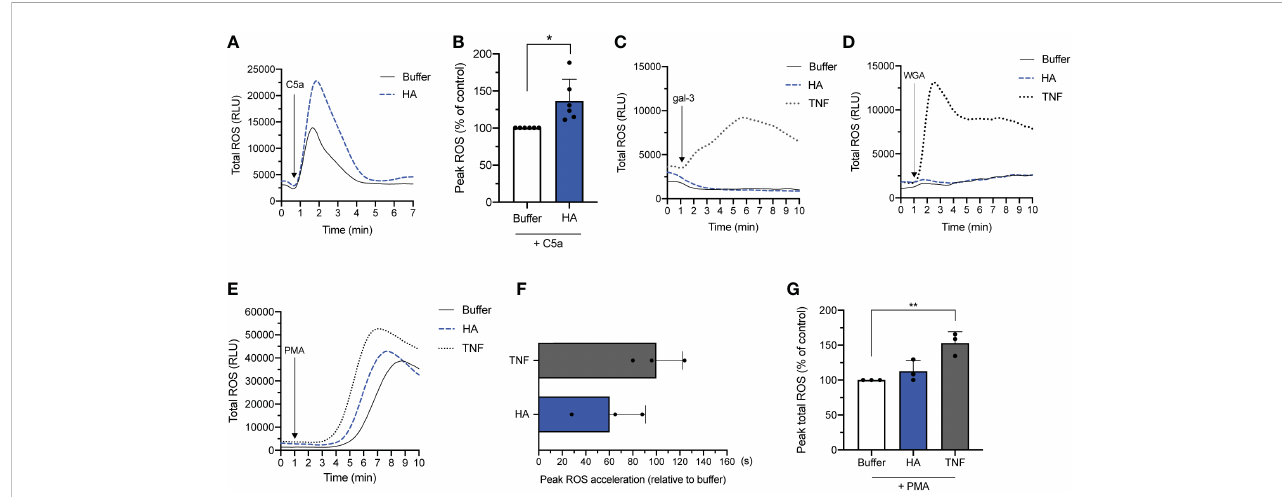
FIGURE 1 NADPH oxidase-derived ROS release by HA-primed neutrophils activated with various stimuli. Total ROS production (y-axis, relative light units (RLU)) by neutrophils over time (x-axis, min) after (A) priming without (buffer) or with HA (200 m g/mL) followed by addition of C5a (50 nM). Data is representative of 6 independent experiments. (B) Bar graphs show total ROS production (y-axis) of unstimulated (buffer) and HA-primed cells (HA) after stimulation with C5a (50 nM). The data is presented as mean percentage of peak total ROS (% ROS) + SD normalized to the response of unstimulated neutrophils to C5a, n = 6. (C) . Total ROS release (y-axis, RLU) by neutrophils over time (x-axis, min) after priming in the absence (buffer) or presence of TNF a (10 ng/mL) or HA (200 m g/mL) followed by galectin-3 (20 m g/mL) or (D) WGA (wheat germ agglutinin; 10 m g/mL). Data is representative of 2 independent experiments. (E) Total ROS release (y-axis, RLU) by neutrophils over time (x-axis, min) after priming in the absence (buffer) or presence of TNF a (10 ng/mL) or HA (200 m g/mL) followed by PMA (5 nM). Data representative of 3 independent experiments. (F) Bar graphs show the acceleration in reaching peak ROS (x-axis, seconds; mean + SD) by cells primed with TNF a or HA relative to unprimed cells after PMA activation. (G) Bar graphs show total ROS production of unstimulated (buffer) and HA-primed cells (x-axis) after stimulation with PMA (5 nM). The data is presented as mean percentage of peak total ROS (% ROS) + SD normalized to the response of unstimulated neutrophils to PMA, n = 3. Statistical analysis was performed using two-tailed paired t-test (B) or repeated measures one-way ANOVA followed by Dunnett ’ s multiple comparisons test, (G) ; *p < 0.05, **p <